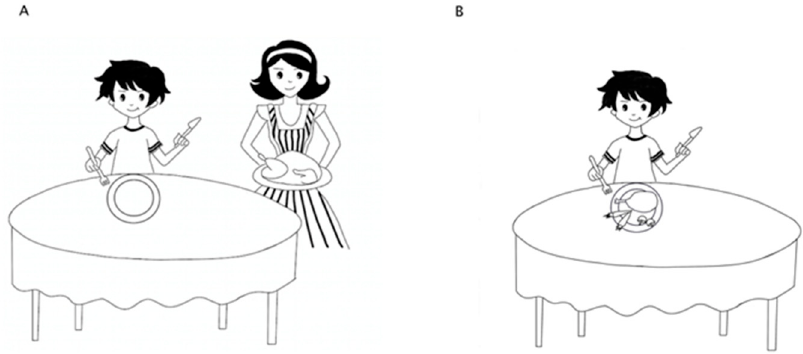
Figure 1. Picture-matching task (PMT) drawing.